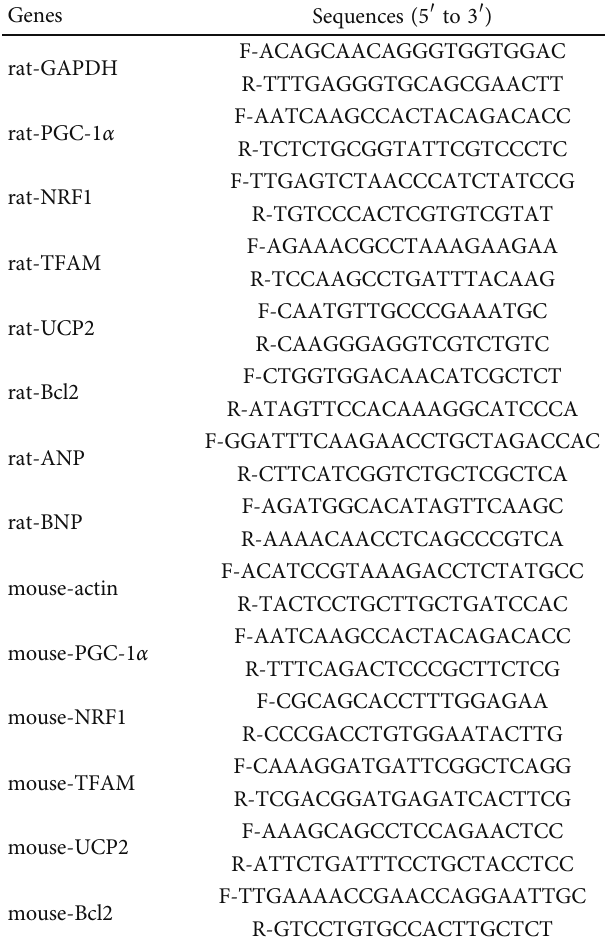
Table 1: Primers used in the study. Genes Sequences (5 ′ to 3 ′